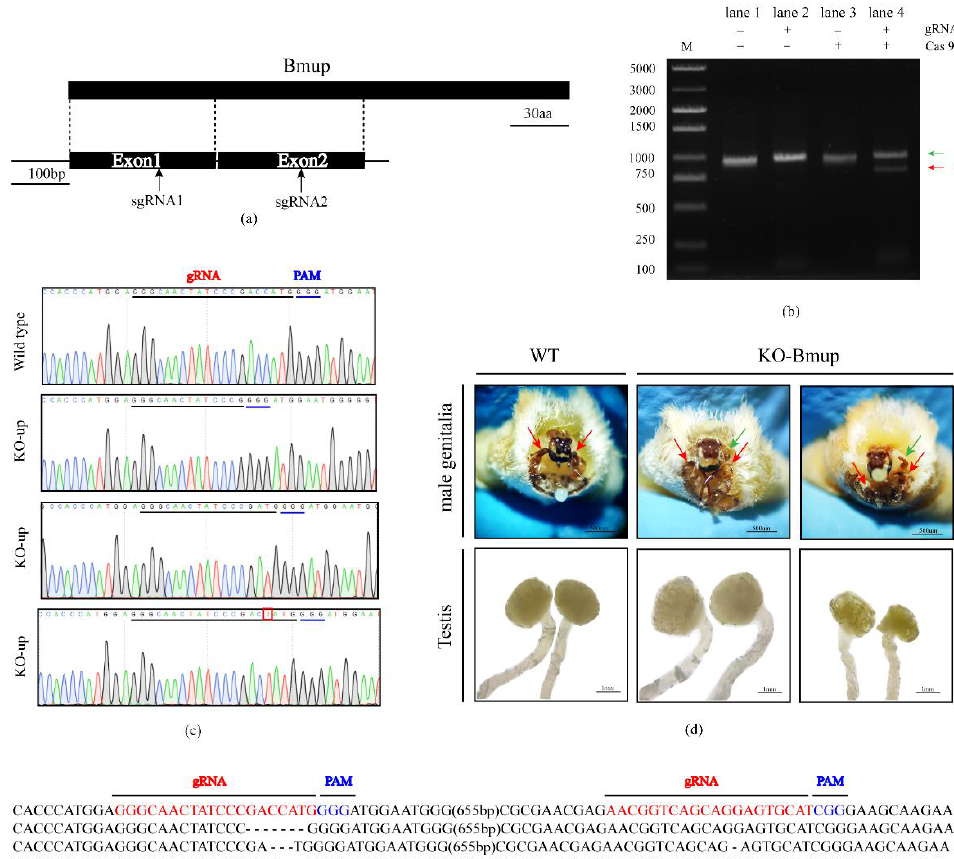
Figure 2. CRISPR/Cas9 mediated mutagenesis of BmUP . ( a ) Locations of sgRNAs relative to the BmUP gene. ( b ) Analysis of cleavage products by gel electrophoresis. Lane1, untreated target fragment; lane2, target fragment treated with sgRNA; lane 3, target fragment treated with Cas9 protein; lane 4, target fragment treated with Cas9/sgRNA mixture. The red arrowhead indicates cleaved fragments, and the green arrowhead indicates uncleaved fragments. ( c ) Chromatograms of DNA sequences of wild-type and knockout individuals. The gRNA target site is underlined, and the inserted base is indicated by a red rectangle. ( d ) Phenotype and gonad observation in knockout individuals. WT represents wild-type and KO-up represents knockout individuals. The red arrow represents the clasper, and the green arrow represents hyperplastic tissue. ( e ) Mutation sequences at the target sites of BmUP induced by CRISPR/Cas9. The wild-type sequence is shown on the first line, the sequences of sgRNA-targeted sites are in red and the protospacer adjacent motif (PAM) sequences are shown. Dotted lines represent missing bases, and bold letters represent alternative bases.